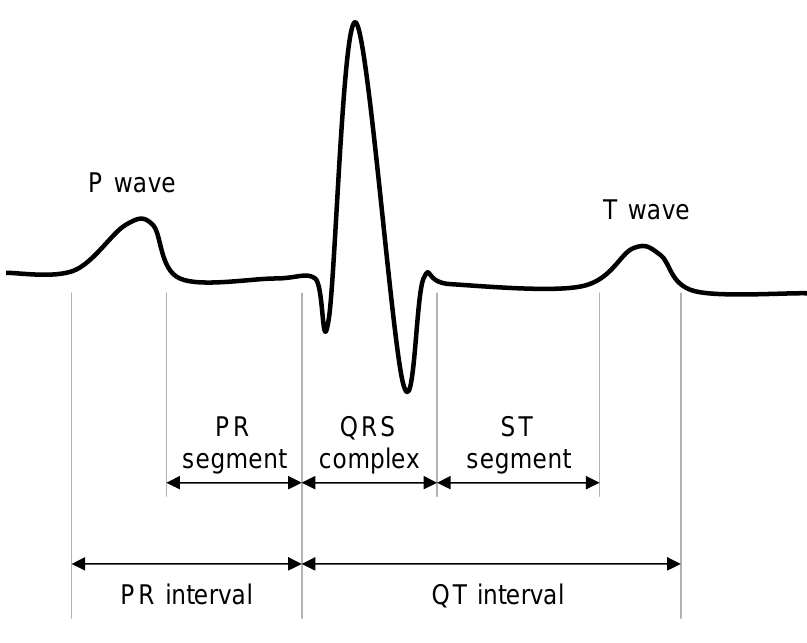
Figure 4. A typical ECG signal for a single